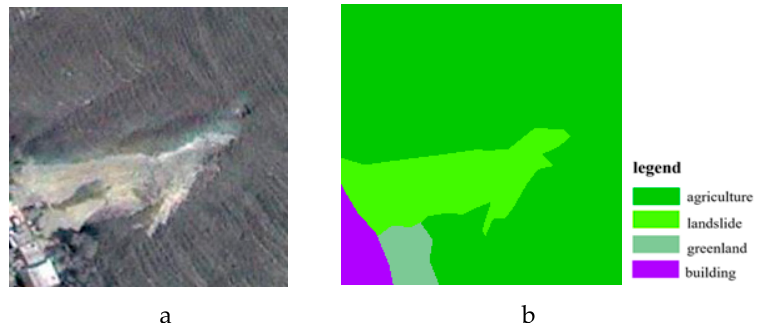
Figure 3. An example of the samples and its ground truth (GT) used in this paper. ( a ) is the original image, while ( b ) is the corresponding GT. There are 4 classes in this sample: landslide, greenland, agriculture and building. In the GT, a specific color was given to every class of the geographic objects.